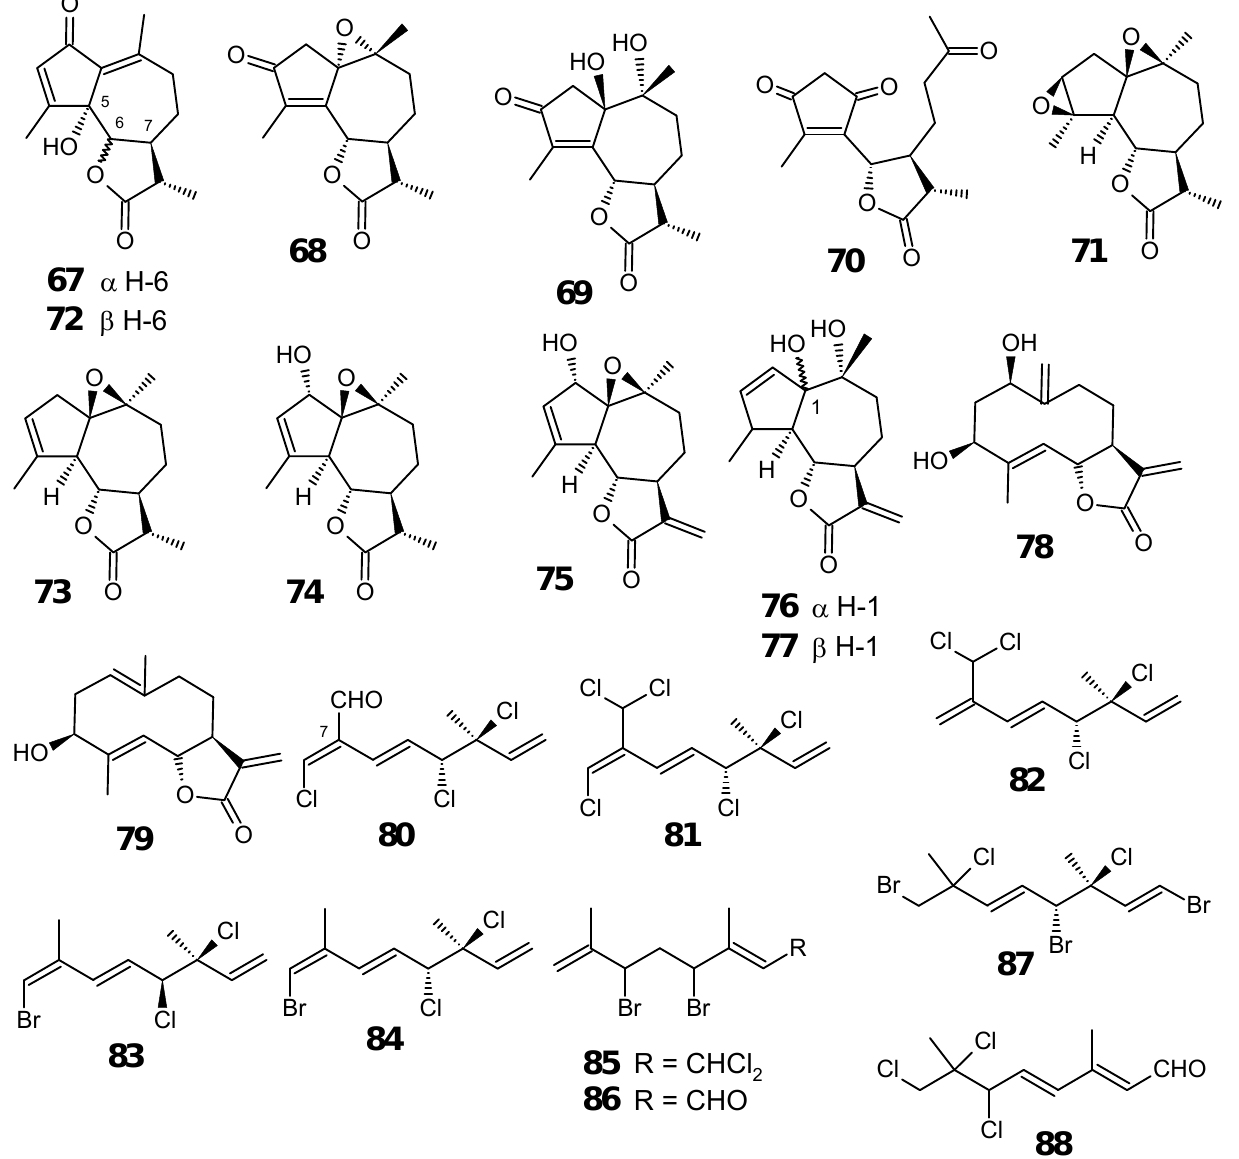
Figure 9. Antiplasmodial terpenes and related compounds 67-88